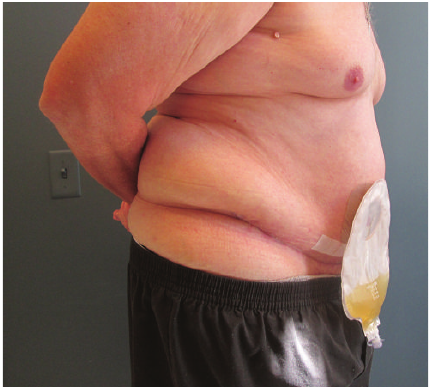
Figure 3: Well-healed incisions and uniform contour of abdominal wall six weeks following radical cystectomy with concomitant panniculectomy. Thepatientexperiencedgoodostomyfunctionand ease of fitting his